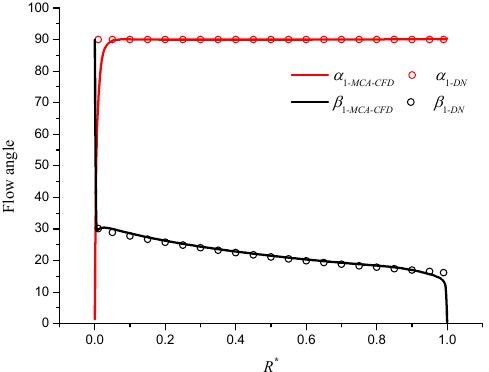
Figure 19. Distribution of liquid flow angle at impeller inlet with radial coefficient.